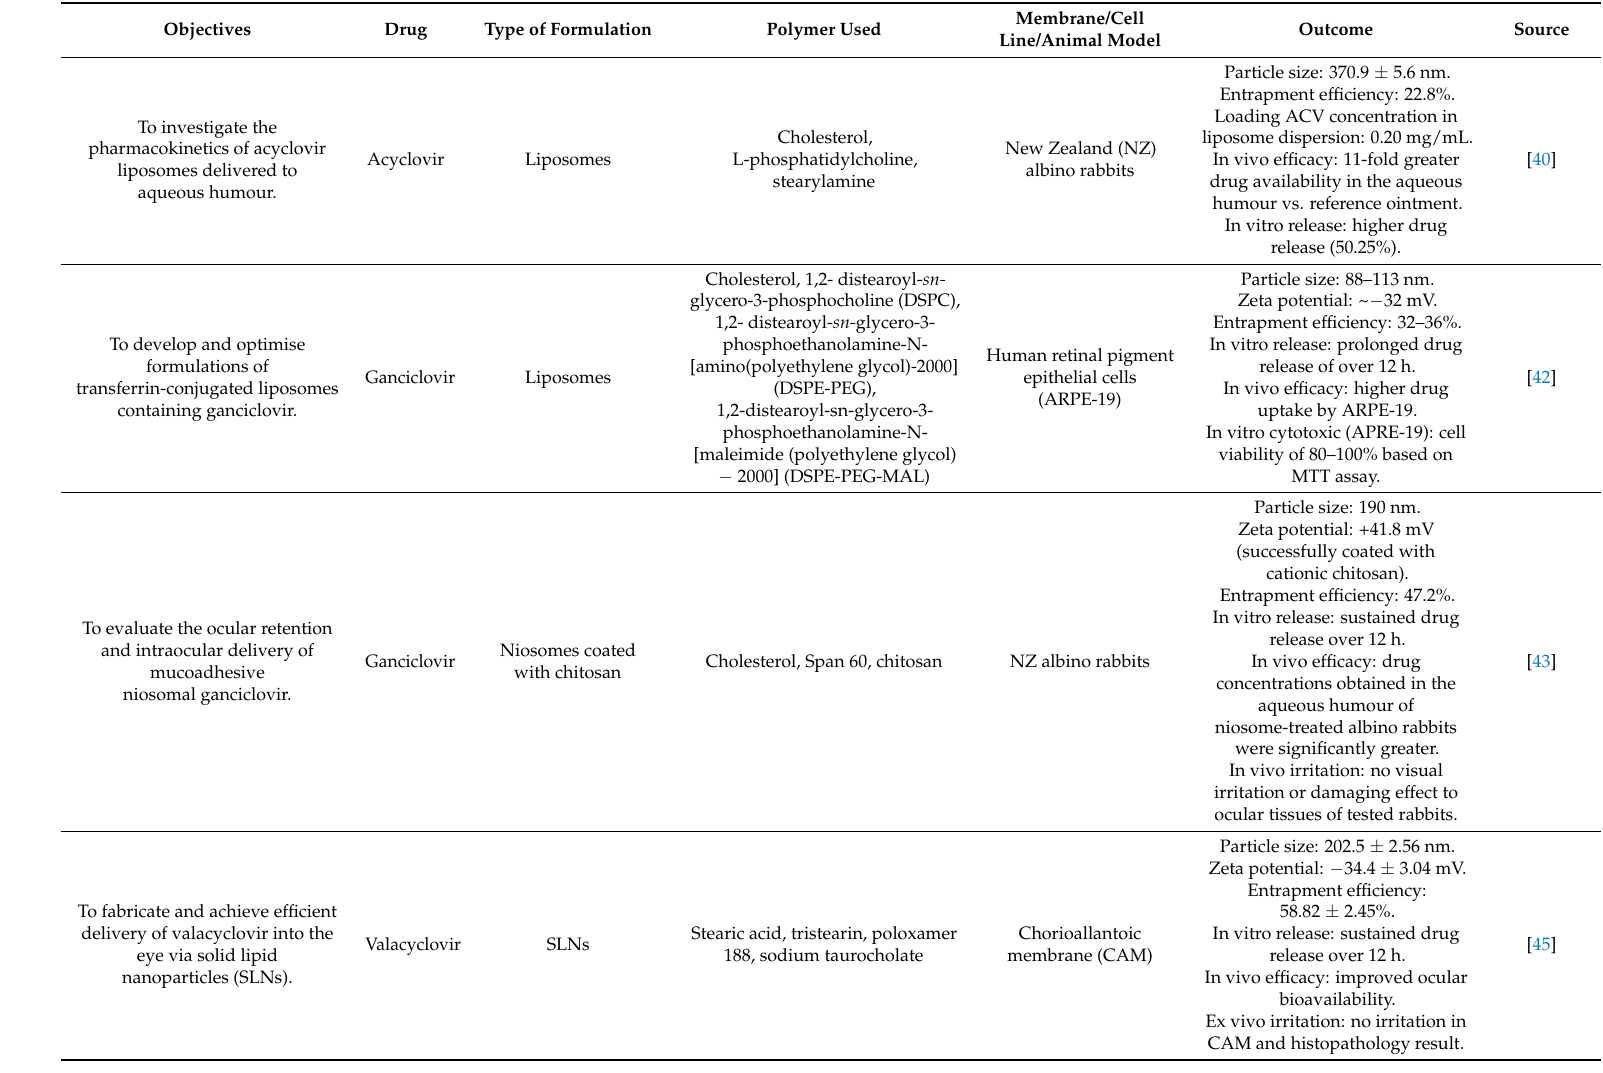
Table 1. Lipid-based nanocarriers for ocular delivery against herpes simplex virus